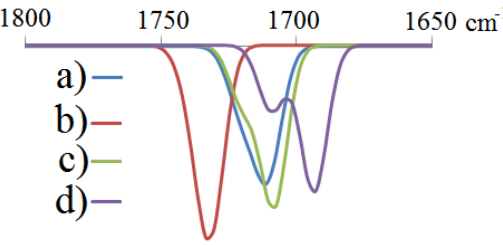
Figure 3. Simulated infrared spectra of the possible complexes. The letters ( a )–( d ) corresponds to the molecules in Figure 2, with M = Zn.